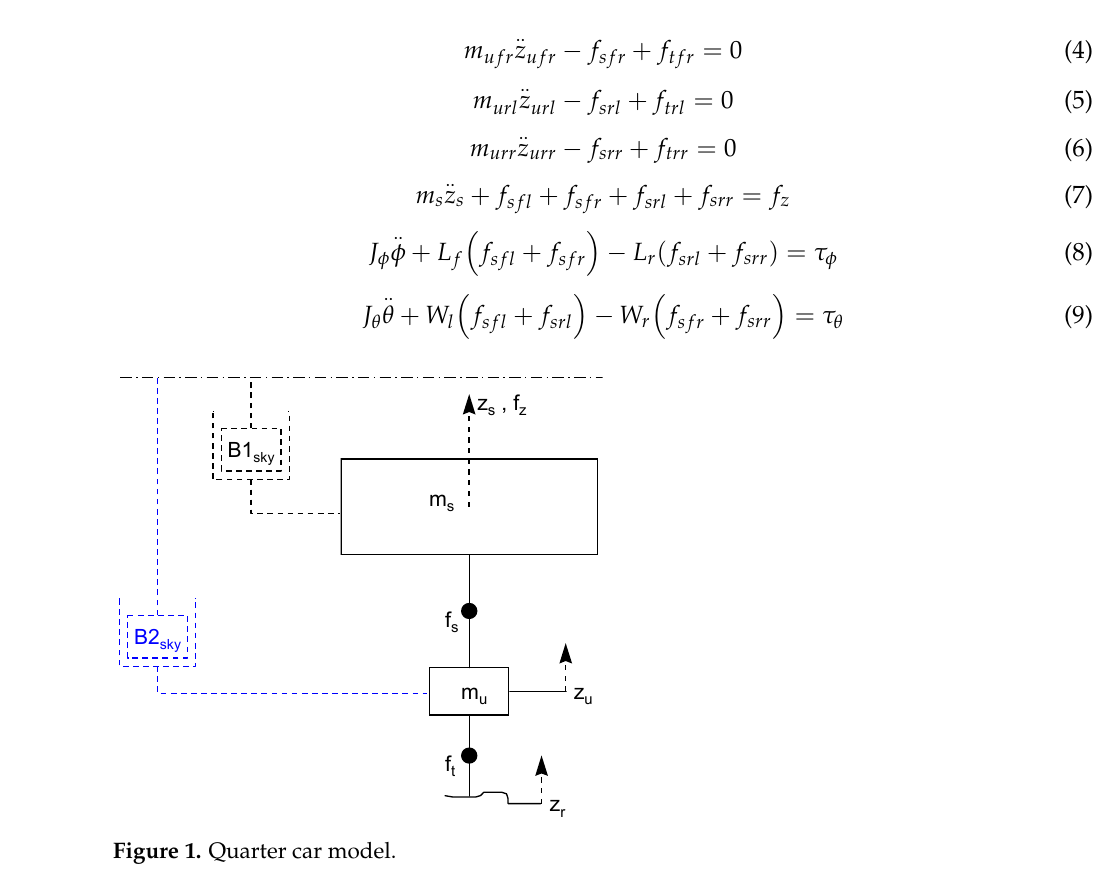
Figure 1. Quarter car model.